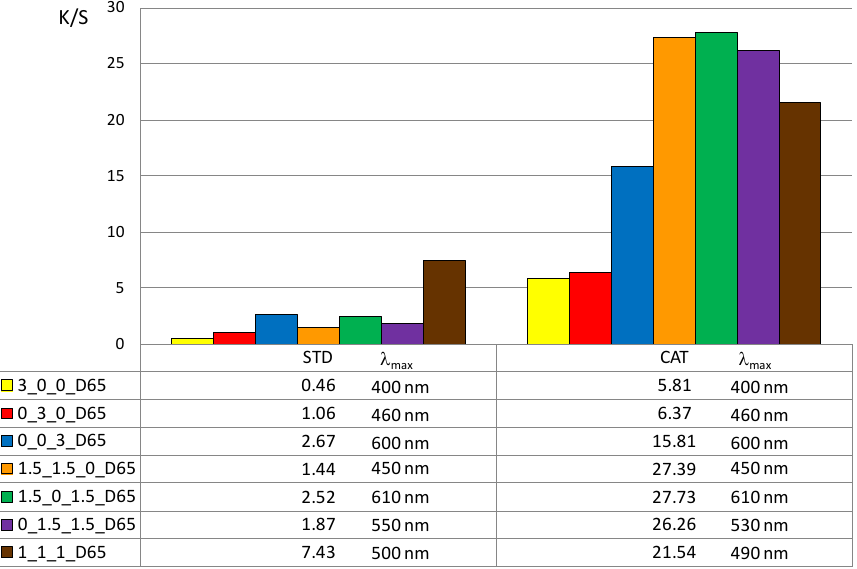
Figure 6. Maximum K/S values of standard and cationized fabric dyed with 3% owf dye.